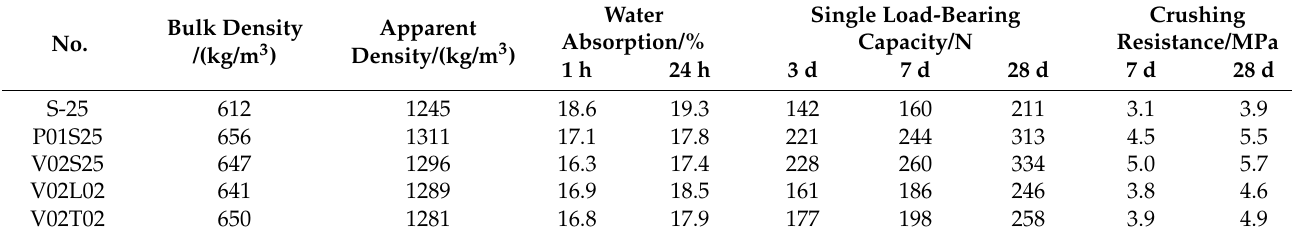
Table 7. Basic properties of CSLA.